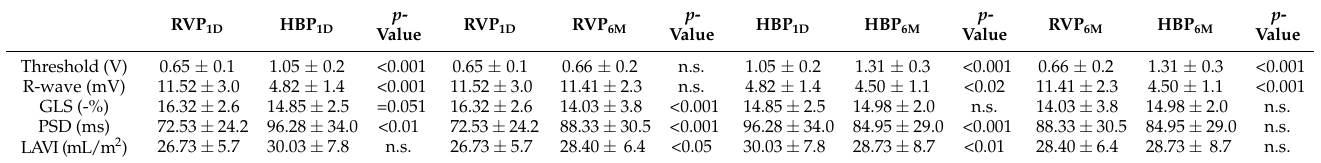
Table 2. Comparison of selected variables between (and within) RVP and HBP groups of patients immediately after pacemaker implantation (1D) and at 6-month follow-up visit (6M). Abbreviations: RVP—right ventricular pacing; HBV— His bundle pacing; GLS—global longitudinal strain; PSD—peak systolic dispersion; LAVI—left atrial volume index.